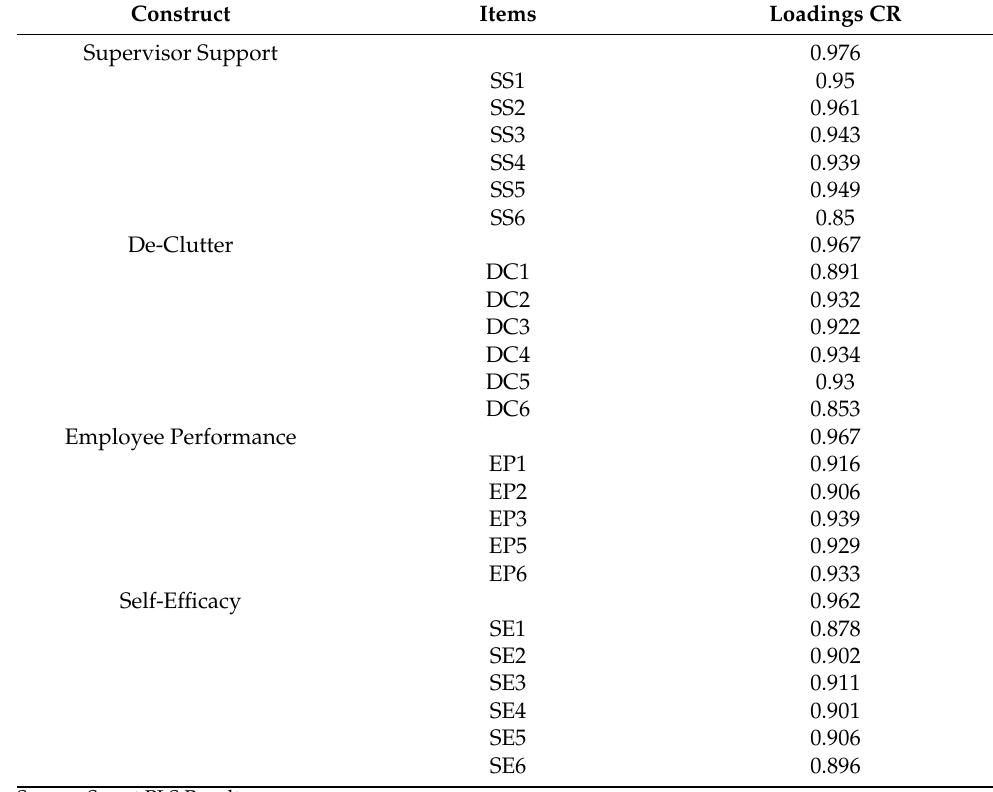
Table 2. Factor Loadings and Composite